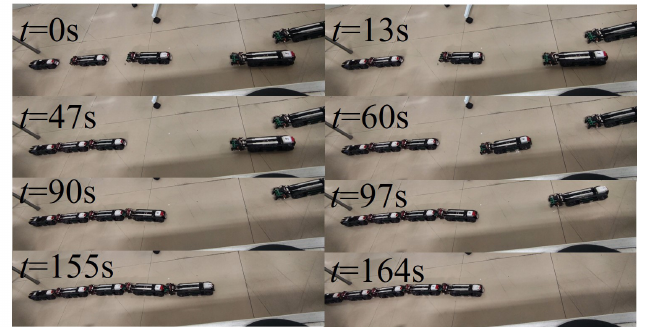
Figure 17. Experiments on the self-assembly of a snake-like composite entity consisting of one SMMRob head module and four body modules and collective motion in a chain.